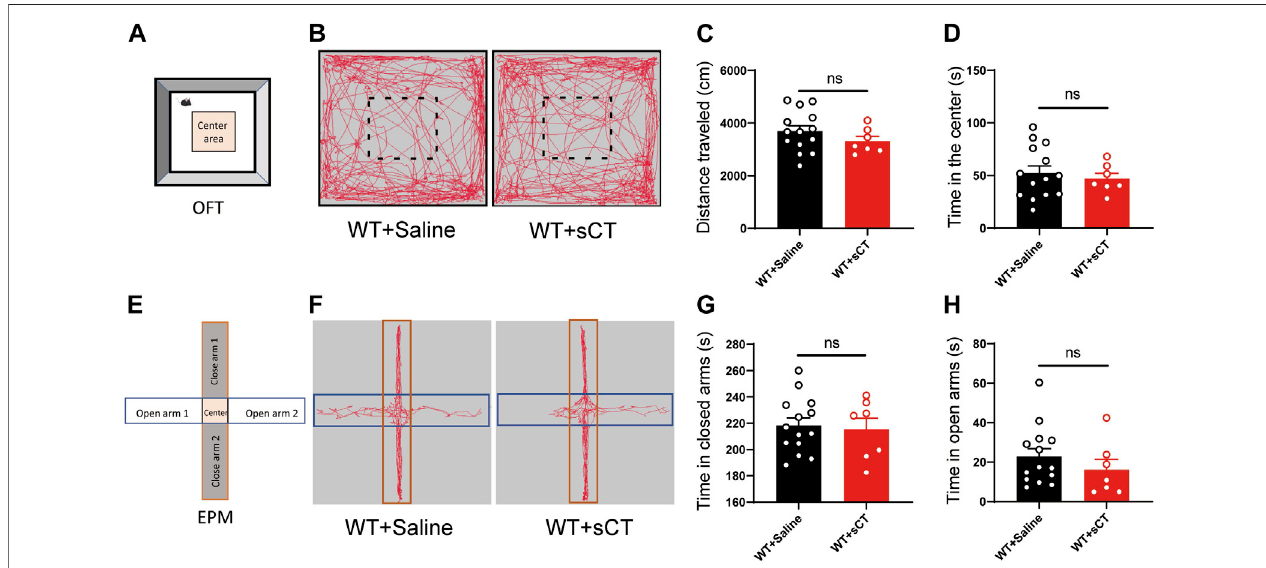
FIGURE 4 | Salmon calcitonin (sCT) did not affect locomotion and anxiety level in WT mice. Scheme of the OFT (A) . Representative images of movement trace in OFT (B) . The distance travelled in OFT did not change with application of sCT (WT + saline: n = 14; WT + sCT: n = 7) (C) . Time in the center did not change with the applicationofsCT (D) .SchemeoftheEPM (E) .Representativeimages ofmovementtracein EPM (F) . Time inclosed arms did notchangewithapplication ofsCT(WT+ saline: n = 14; WT + sCT: n = 7) (G) . Time in open arms did not change with the application of sCT (H) . The data were analyzed by unpaired t -test. WT, wild type; OFT, open fi eld test; EPM, elevated plus